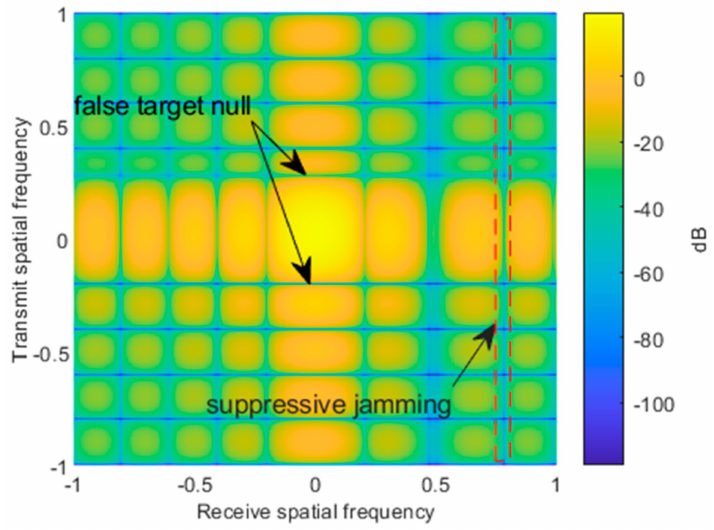
Figure 9. Two-dimensional transmit–receive adaptive